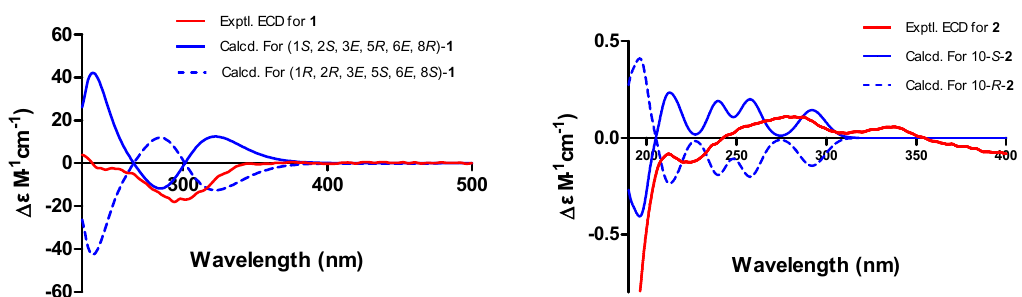
Table 1. Antimicrobial activities of compounds 1 – 5.